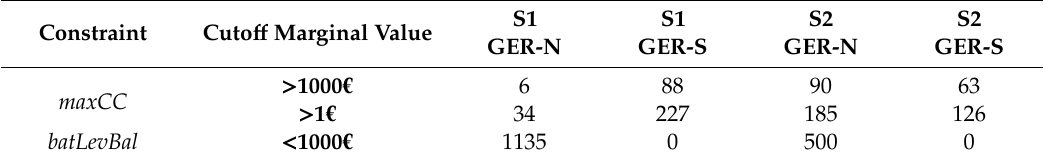
Table 9. Number of hours in which the marginal value of the constraints maxCC (BEV fleet charging connection) and batLevBal (battery balance) is higher or lower than the cuto ff -values given in the second column. All numbers are only given for the fleet of medium-sized